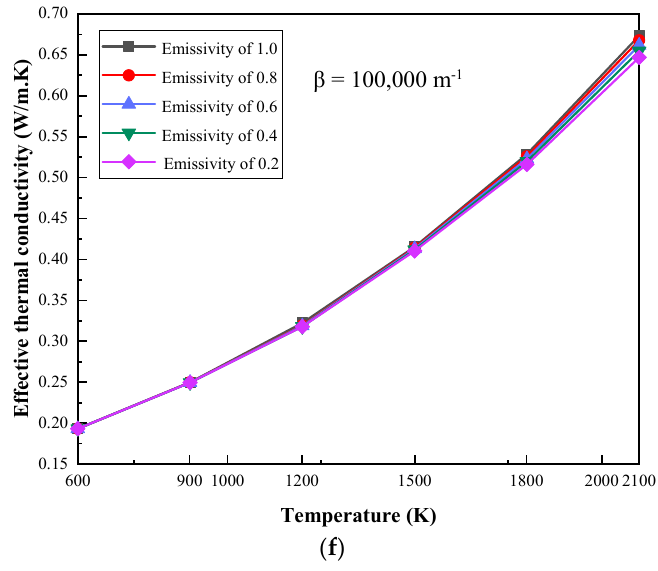
Figure 5. The variation in ETC with different boundary temperatures: ( a ) β = 50 m −1 , ( b ) β = 500 m −1 , ( c ) β = 1000 m −1 , ( d ) β = 5000 m −1 , ( e ) β = 20,000 m −1 , ( f ) β = 100,000 m −1 .